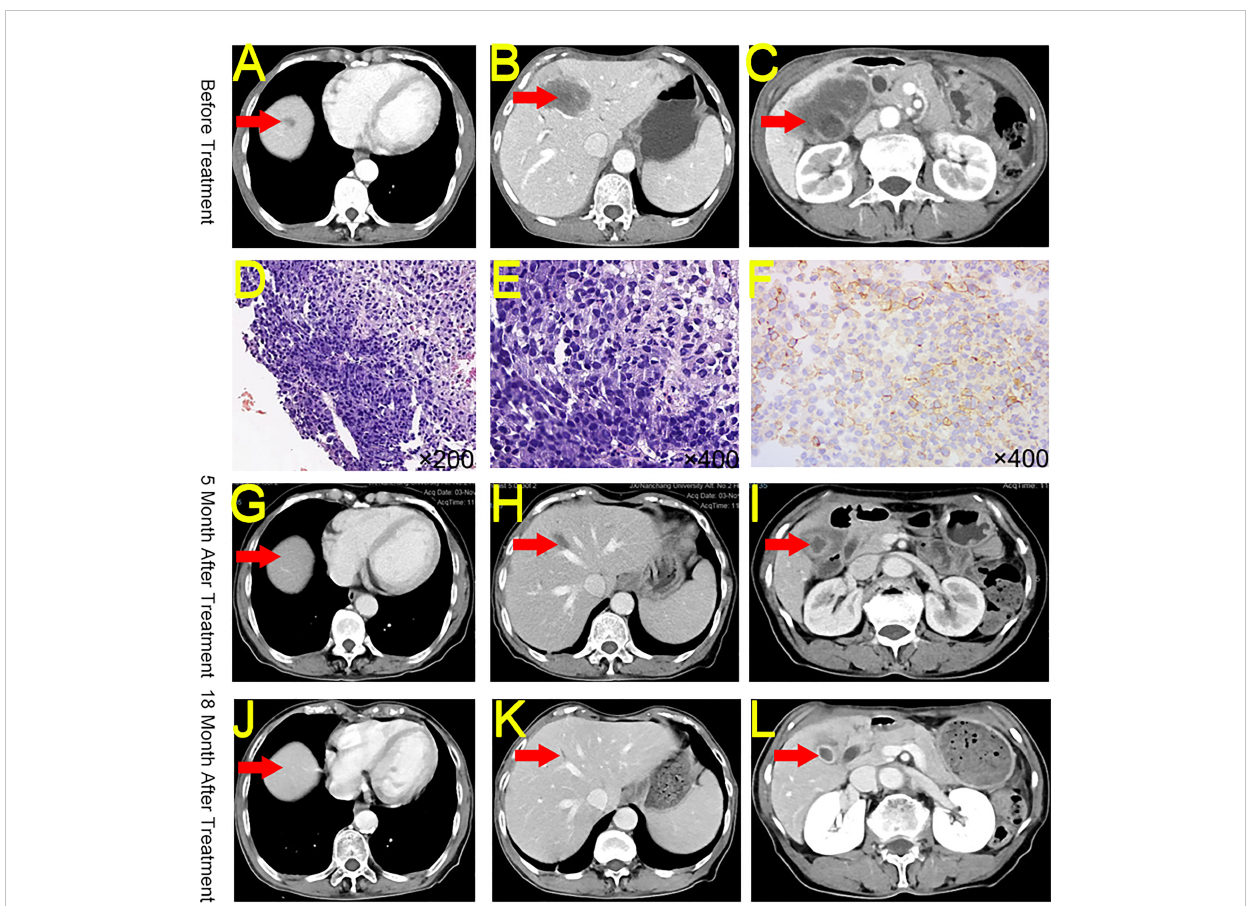
FIGURE 2 CECT, HE, and Immunohistochemistry for Case 2. (A) Intrahepatic mass at diagnosis. (B) A second intrahepatic mass at diagnosis. (C) Peri-gallbladder condition at diagnosis. (D) Hematoxylin and eosin staining of biopsy tissue (original magni fi cation ×200). (E) Hematoxylin and eosin staining of biopsy tissue (original magni fi cation ×400). (F) PD-L1 staining of biopsy tissue (original magni fi cation ×400). (G) The reduction of the intrahepatic mass after 5 months of treatment. (H) Signi fi cant reduction in a second intrahepatic mass after 5 months of treatment. (I) Signi fi cant reduction in the peri-gallbladder mass after 5 months of treatment. (J) Persistent reduction of the intrahepatic mass after 18 months of treatment. (K) Persistent reduction in a second intrahepatic mass after 18 months of treatment. (L) Persistent reduction in the peri-gallbladder mass after 18 months of treatment. CECT, contrast-enhanced computed tomography; HE, hematoxylin and eosin; PD-L1, Programmed Cell Death-Ligand